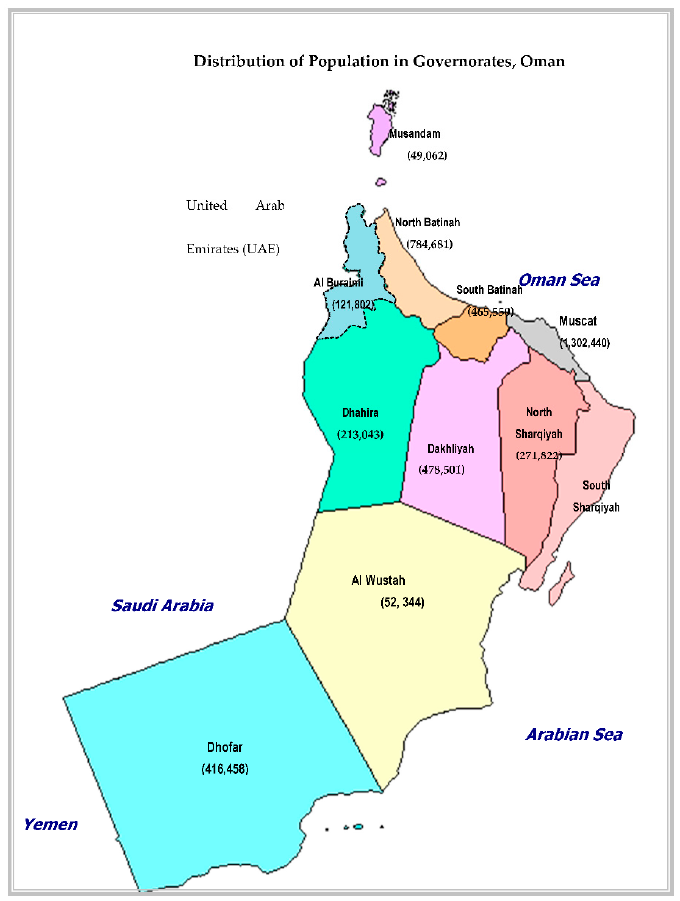
Figure A1. Distribution of Omani population according to governorates, Year 2021, Oman.